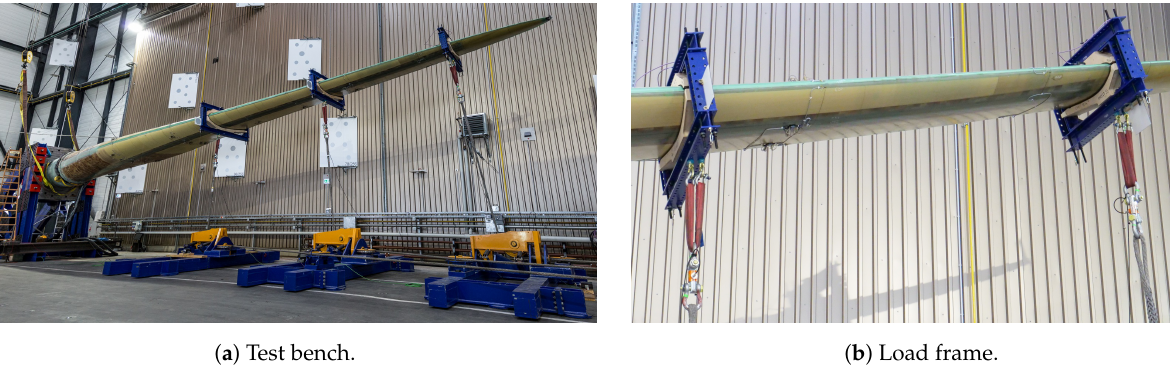
Figure 1. Experimental setup for load case Mymax by Fraunhofer IWES